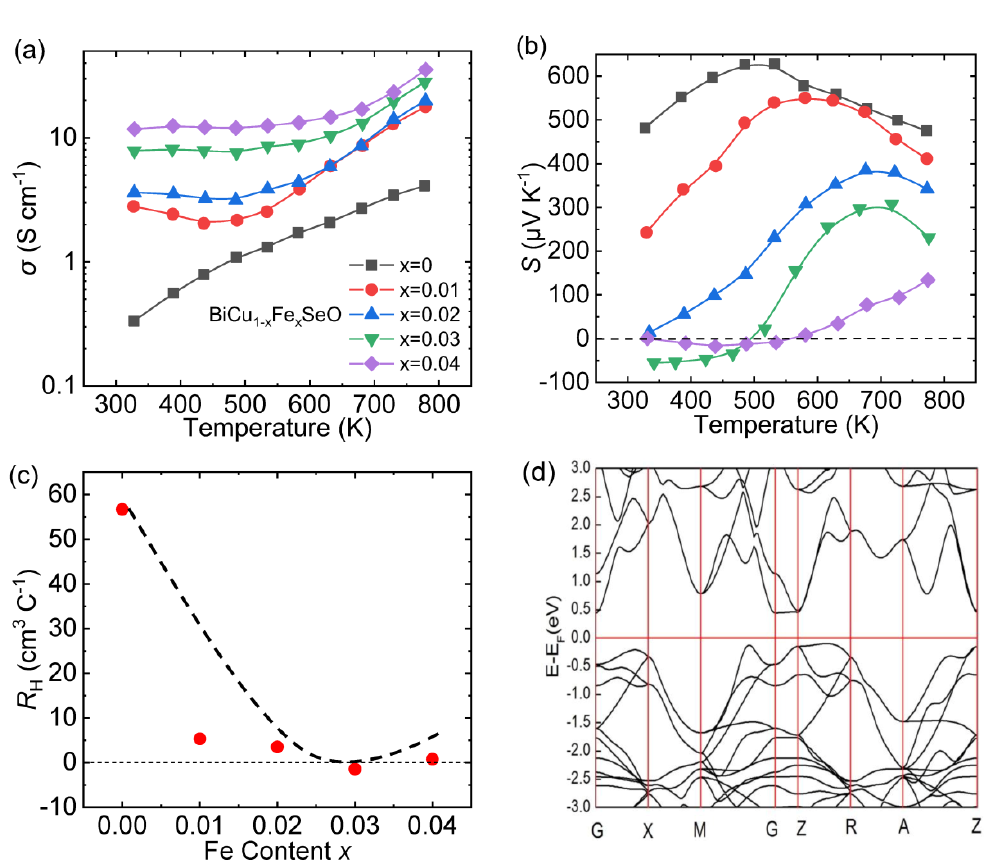
Figure 2. The curves of ( a ) electrical conductivity, and ( b ) Seebeck coefficient varying with temperature for BiCu 1-x Fe x SeO ( x = 0 to 0.04); ( c ) Fe content dependences of Hall coefficient for BiCu 1-x Fe x SeO ( x = 0 to 0.04) at room temperature. Data presented in ( a – c ) were adopted from Reference [52]. Copyright 2018, The Royal Society of Chemistry. ( d ) Calculated band structure of pristine BiCuSeO near the Fermi level. Copyright, the Royal Society of Chemistry. ( d ) Reproduced with permission from Reference [55]. Copyright 2019, Elsevier Masson SAS.